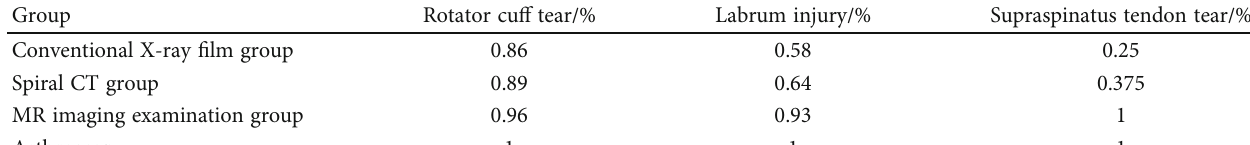
Table 4: The proportion of shoulder joint diagnosed by three